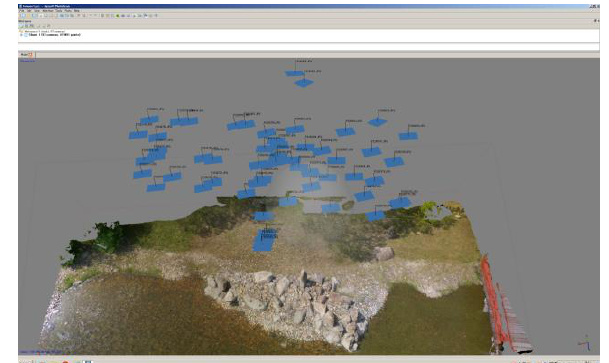
Figure 10. Camera position and reconstructed model from UAV